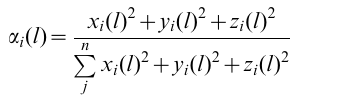
Figure S1 MD simulations of KIT cytoplasmic region with cleaved JMR in the inactive form. The RMS deviations (in A˚ ) were calculated from MD simulations of truncated wild-type Kit, WT 567–935 (in green), and D816V mutant, MU 567–935 (in purple), on the backbone atoms of: ( a ) the whole protein, ( b ) N-lobe, ( c ) C- lobe, ( d ) A-loop and ( e ) JMR, with respect to the initial frame. The dashed grey vertical line drawn at 2 ns indicates the relaxation time. Figure S2 Relative free energies of active versus inactive states of wild-type and D816V-mutated KIT truncated CR. Free energies were computed on the equilibrated conformations of WT 567–935 and MU 567–935 in the inactive (I) and active (A) states. Figure S3 Superimposition of KIT inactive 50-ns MD confor- mations and active X-ray structure. The 50-ns final MD conformations of WT 547–935 (in opaque and transparent dark blue), of MU 547–935 (in opaque and transparent red), of WT 567–935 (in green) and of MU 567–935 (in purple), and the X-ray structure 1PKG (chain B, in transparent black) were superimposed. ( A ) On the left are displayed the JMR (residues 553 to 581 for 1PKG,WT 547–935 and MU 547–935 , residues 567 to 581 for WT 567–935 and MU 567–935 ), helix C and its preceeding loop (residues 627 to 648) and the A-loop (residues 810 to 839), in cartoon representation; on the right is displayed a zoom of the 820–839 part of the A-loop and an helix from the C-lobe that serves as a platform for the substrate in 1PKG (residues 874 to 887). ( B ) The table in insert gives the atomic fluctuations mean, maximum and median values in A˚ 2 for JMR. Figure S4 Degrees of collectivity of JMR atomic motions. Normal mode analysis was performed on (i) the crystallographic structure 1T45 of wild-type KIT cytoplasmic region, (ii) four conformations representative of WT 547–935 MD trajectory 1 , (iii) four conformations representative of MU 547–935 MD trajectory 1 . The degrees of collectivity k JMR were computed on the 97 lowest- frequency modes obtained from each NMA, leading to a total of 97 values for the X-ray structure and 388 values forWT 547–935 and MU 547–935 respectively. The histograms give the distributions of the 388 k JMR values for the wild type (in blue) and the mutant (in red). The dotted lines indicate the corresponding mean k JMR values and the mean k JMR value for the X-ray structure. Figure S5 Total energies and MMFP2 restraints recorded along the 4-A˚ displacement of wild-type and D816V mutated KIT cytoplasmic domain structure along chosen normal modes. Upper Panel: the wild-type, WT 547–935 . Lower Panel: the mutant D816V, MU 547–935 . Plain and dashed lines give the total energy and the MMFP2 restraint respectively, in kcal/mol.